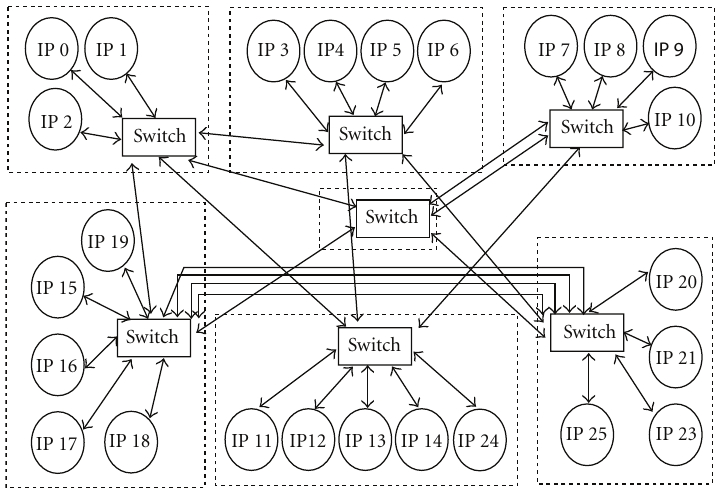
Figure 10: Example